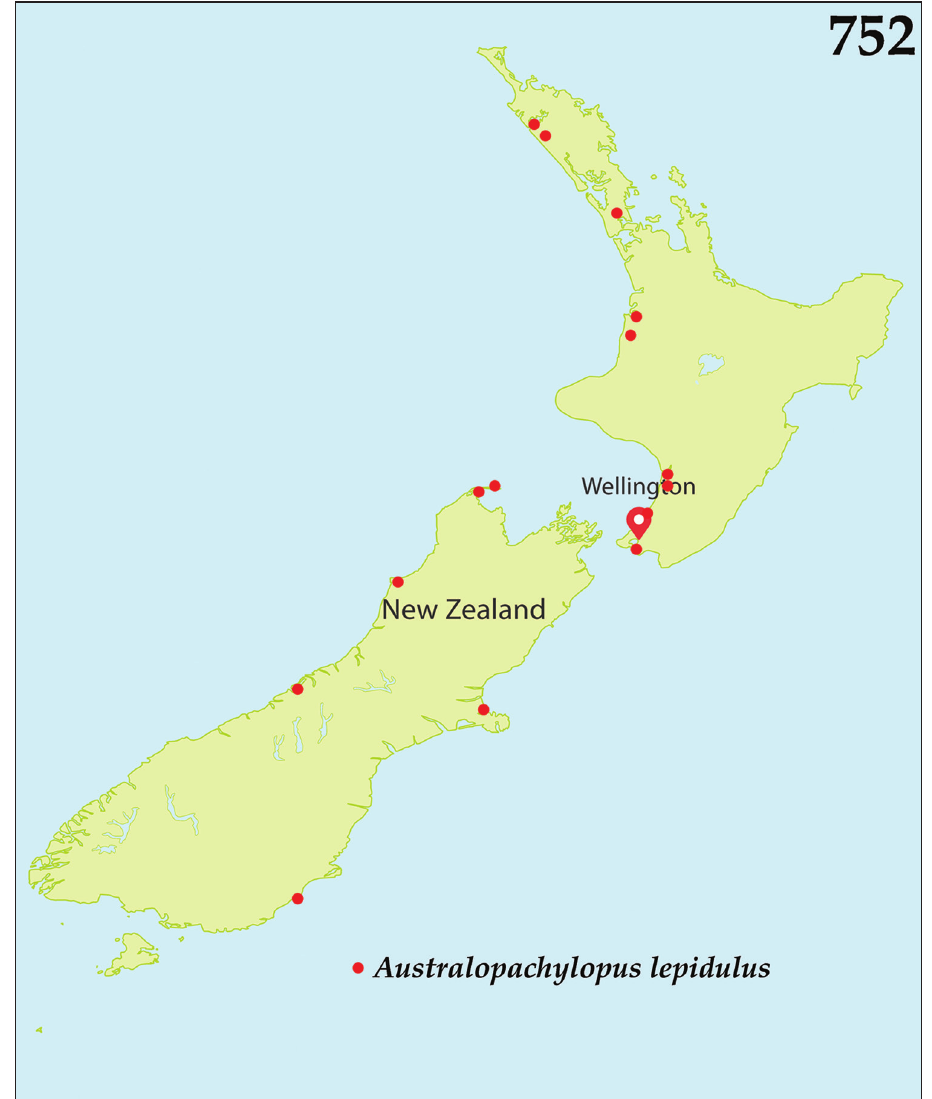
Figure 752. Distribution of Australopachylopus lepidulus (Broun, 1881) in New Zealand. elytral half apically; basal ends of all striae curved; between fourth dorsal elytral and sutural striae a characteristic hooked appendix present, basally occasionally con- nected to basal fragment of sutural elytral stria; sutural elytral stria apart from this basal fragment interrupted on basal third, continued apical two-thirds (roughly), becoming weaker apically. Entire elytral disc punctate, but punctures on basal elytral third (roughly) very fine and sparse, separated several times their diameter, on apical two-thirds (roughly) punctures larger and denser, separated approximately by